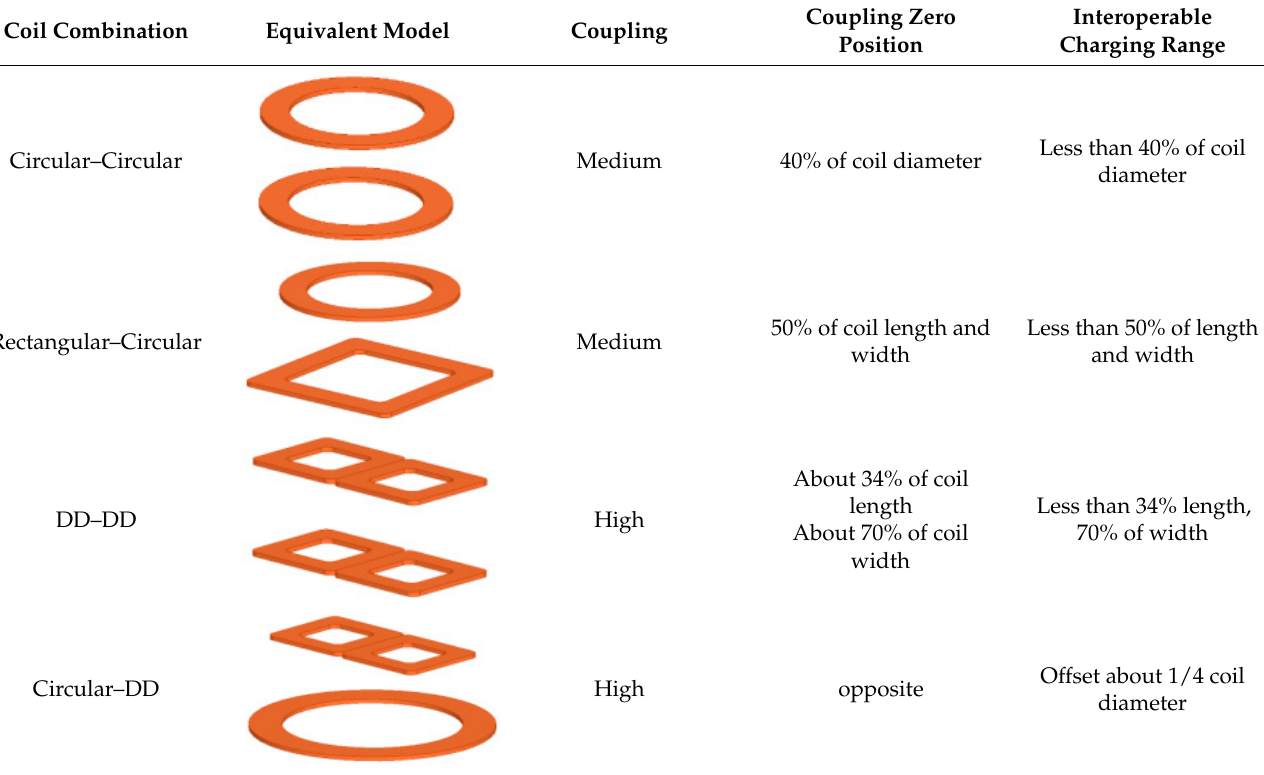
Table 3. Interoperability of several types of coil structures.